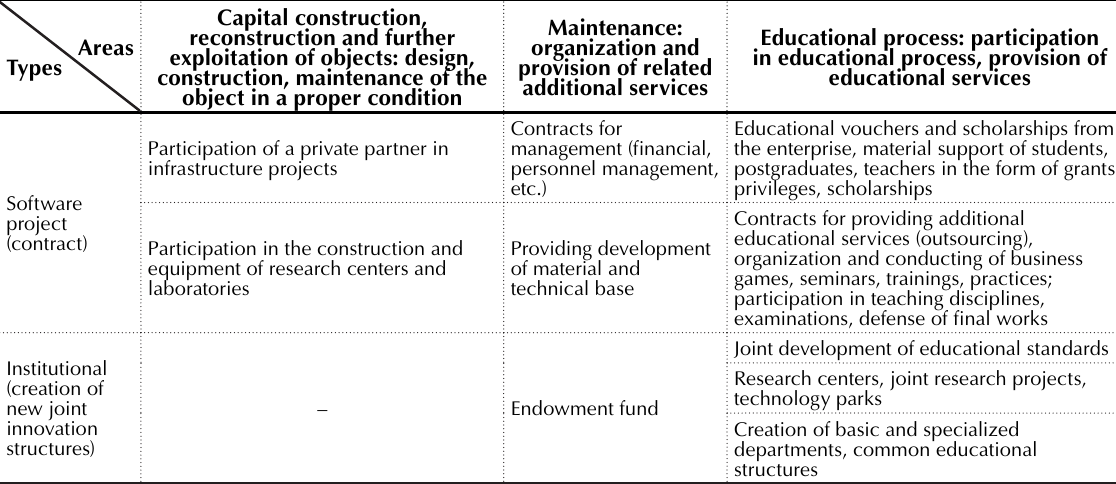
Table 2. Areas and types of interactions between university and business Areas